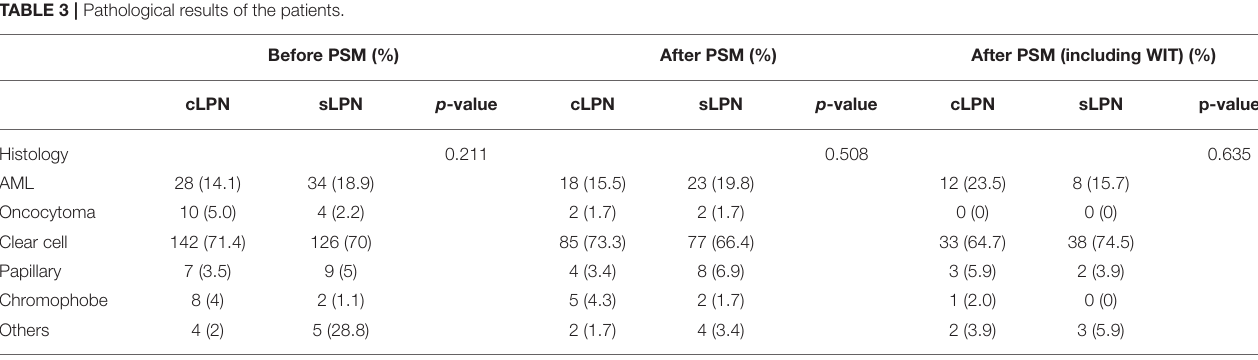
TABLE 3 | Pathological results of the patients.